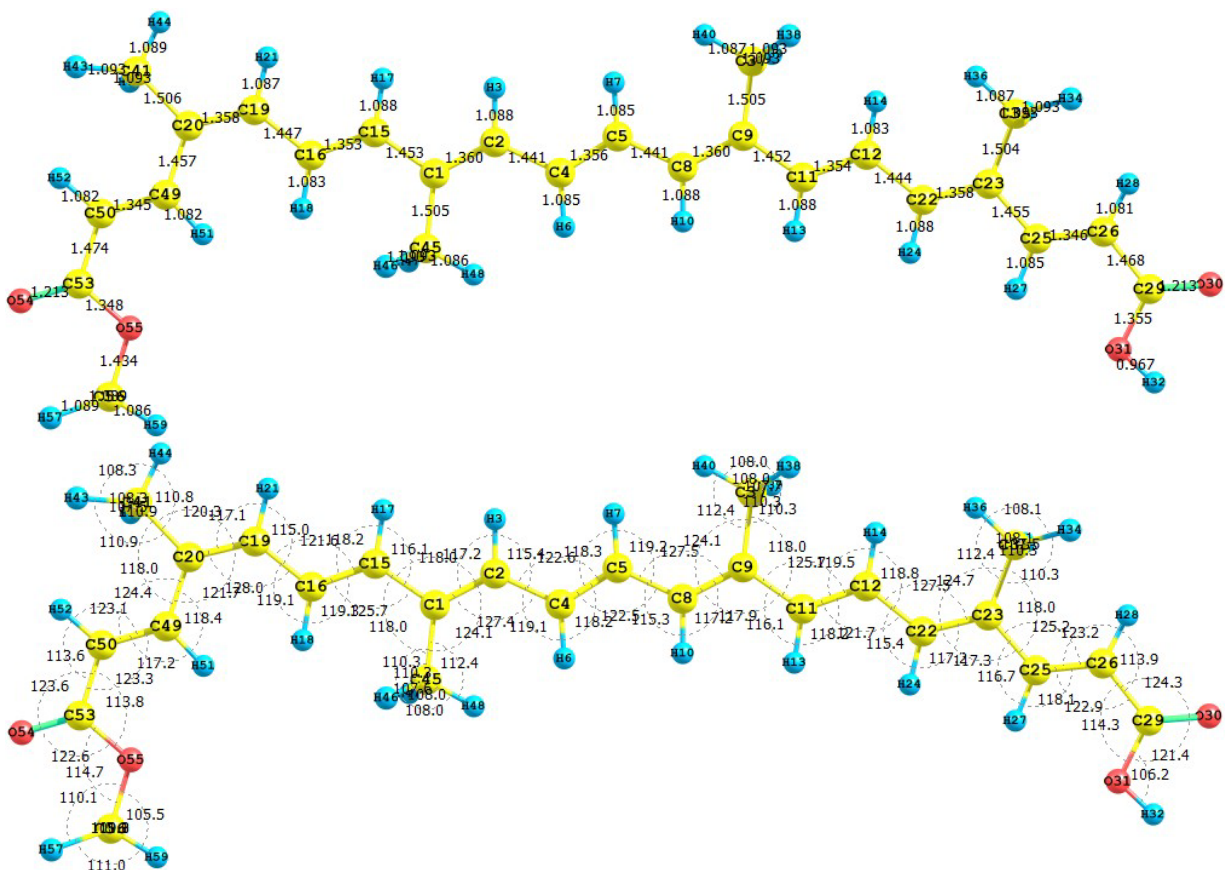
Figure 3. Interatomic bond distances ( Å ) and bond angles (deg) for the bixin